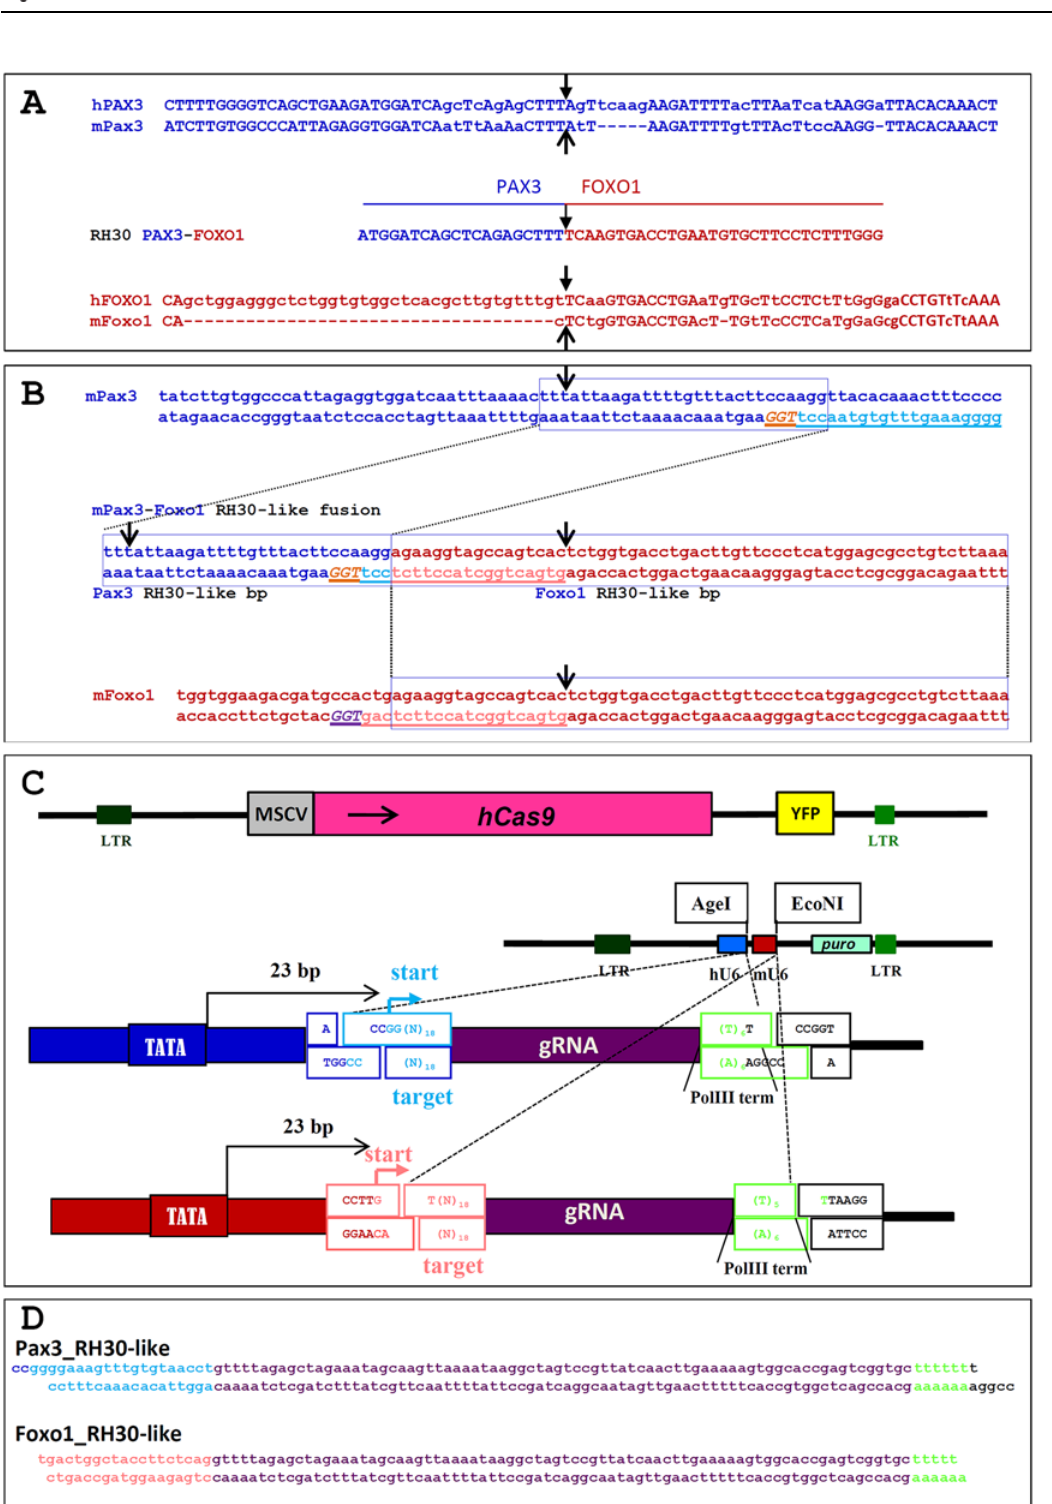
Figure 4. Sequences and vectors used for the generation of an RH30-like t(1;3) in Foxo1-inv +/+ mouse myoblasts. A. Top 2 lines show the sequence alignment of human PAX3 intron 7 (hPAX3) with that of mouse Pax3 intron 7 (mPax3) across the PAX3 breakpoint (black arrow) in the A-RMS cell line RH30. Bottom 2 lines show the sequence alignment of human FOXO1 intron 1 (hFOXO1) with that of mouse Foxo1 intron 1 (mFoxo1) across the FOXO1 breakpoint (black arrow) in RH30. The line in the middle shows the sequence of the t(2;13) breakpoint (black arrow) in RH30. B. Top 2 lines show the sequence of the mouse Pax3 intron 7 across the RH30 breakpoint (black arrow). The targeting sequence of the sgRNA (light blue, underlined) and PAM sequence